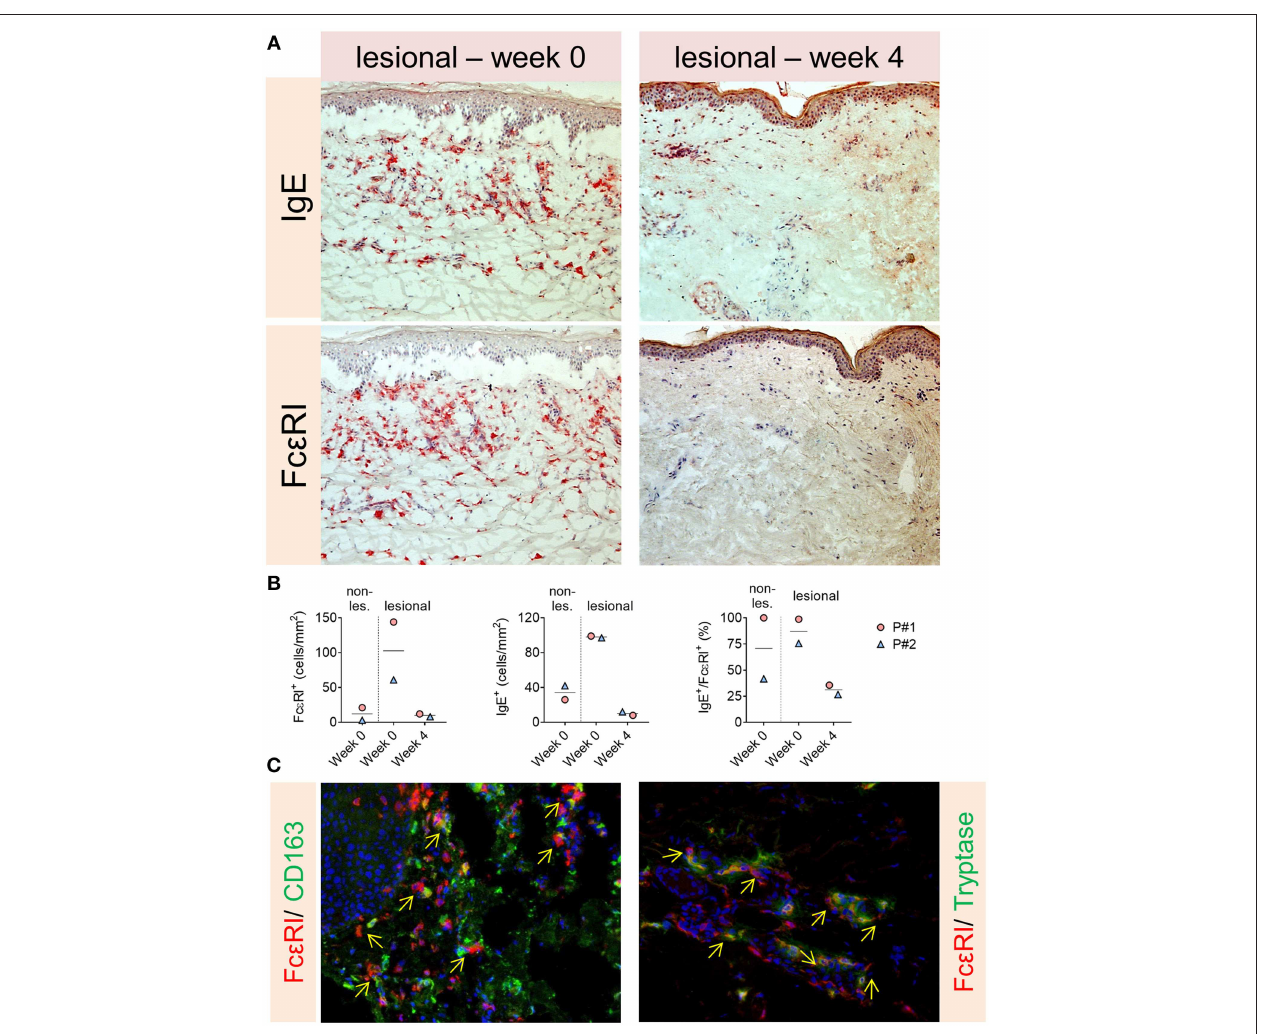
Frontiers in Immunology |